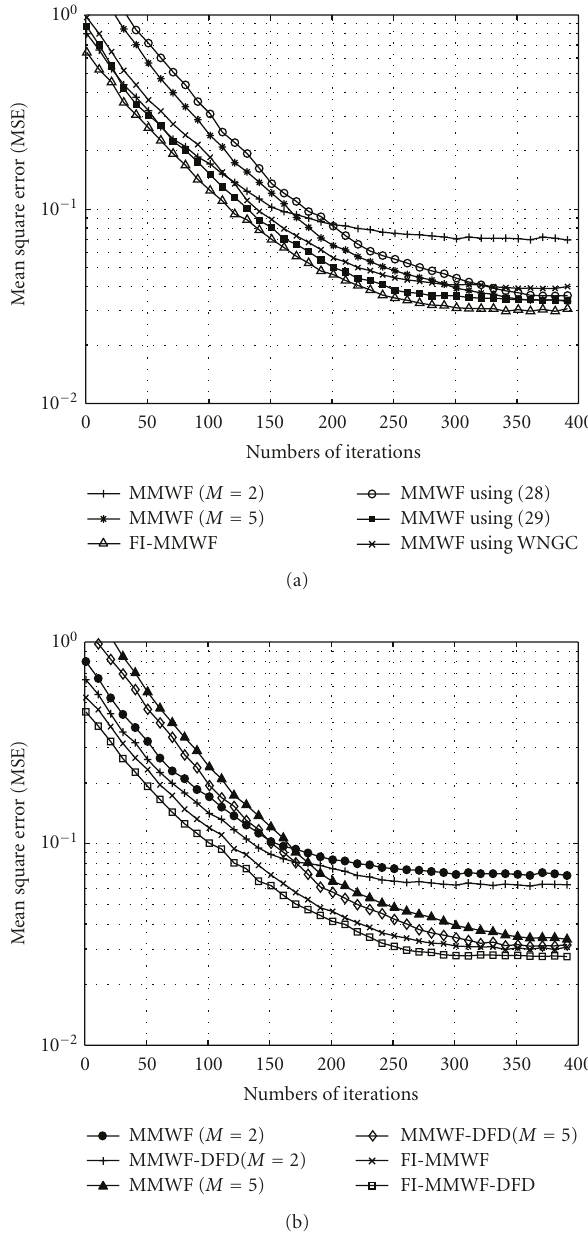
Figure 4: Mean square error versus the number of iterations for blind reduced-rank MMWF-based